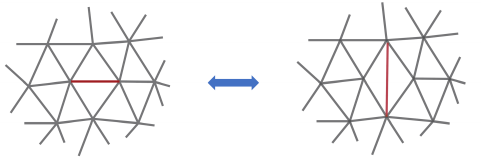
Figure 4. A schematic diagram of the Bond-Flip Monte Carlo method in which the shared edge of two adjacent triangles are clipped and reconnected to the diagonal vertices to change the local topology of the structure